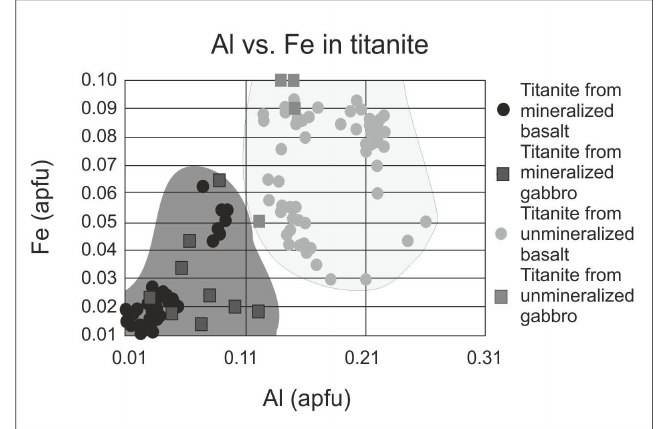
Figure 5. Al vs. Fe content of titanite from mineralized and unmineralized zones. Distinctly different fields can be assigned.